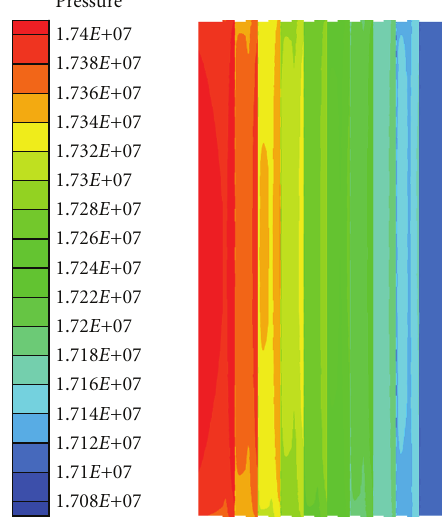
Figure 8: Pressure contour of circumferential grooved stator.